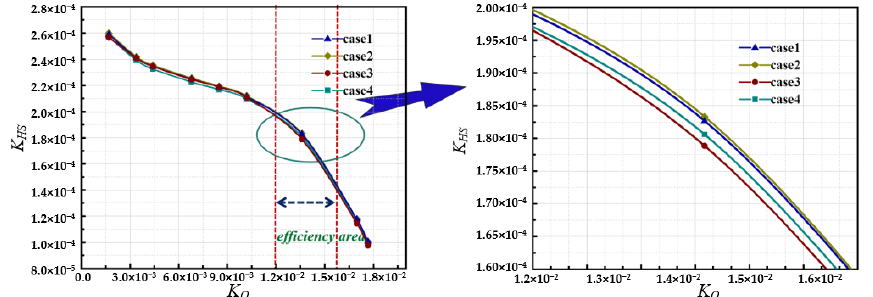
Figure 4. Efficiency ~ flow rate curves.